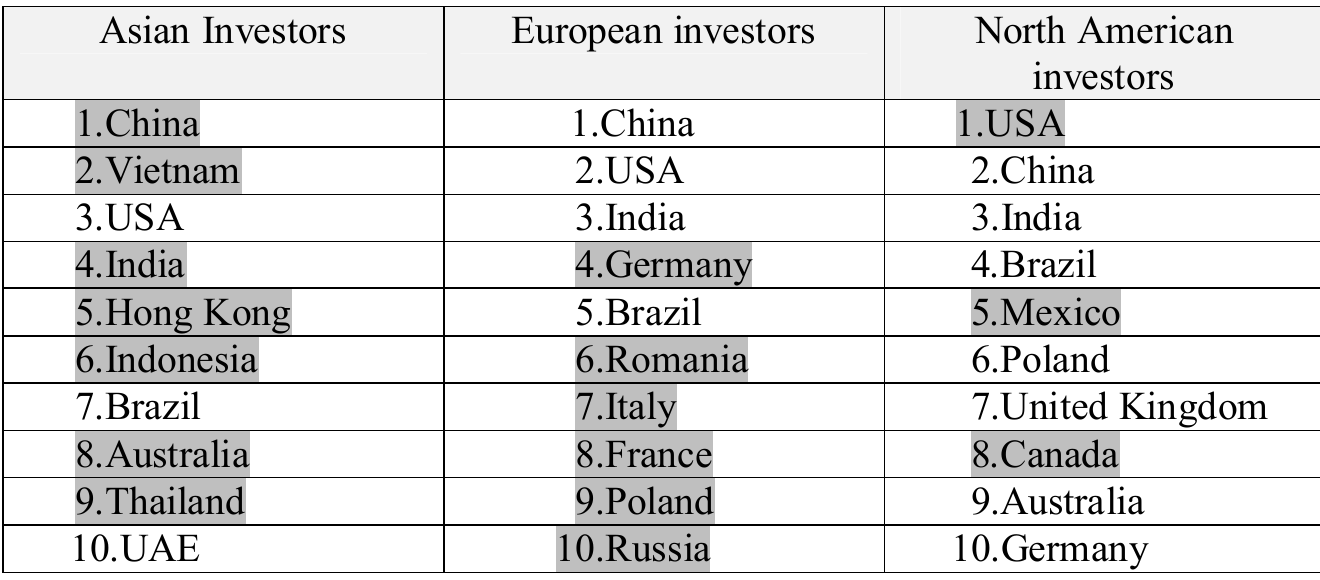
Figure 3 - Investors´ top regional preferences Note: Colour indicates countries in the same region Source: